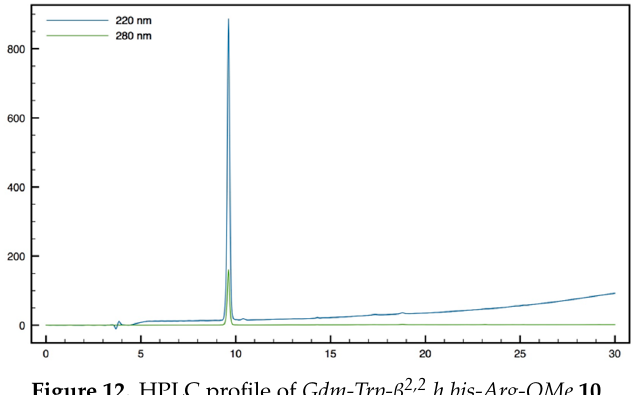
Figure 12 . HPLC profile of Gdm-Trp- β 2,2 h bis-Arg-OMe 10 .